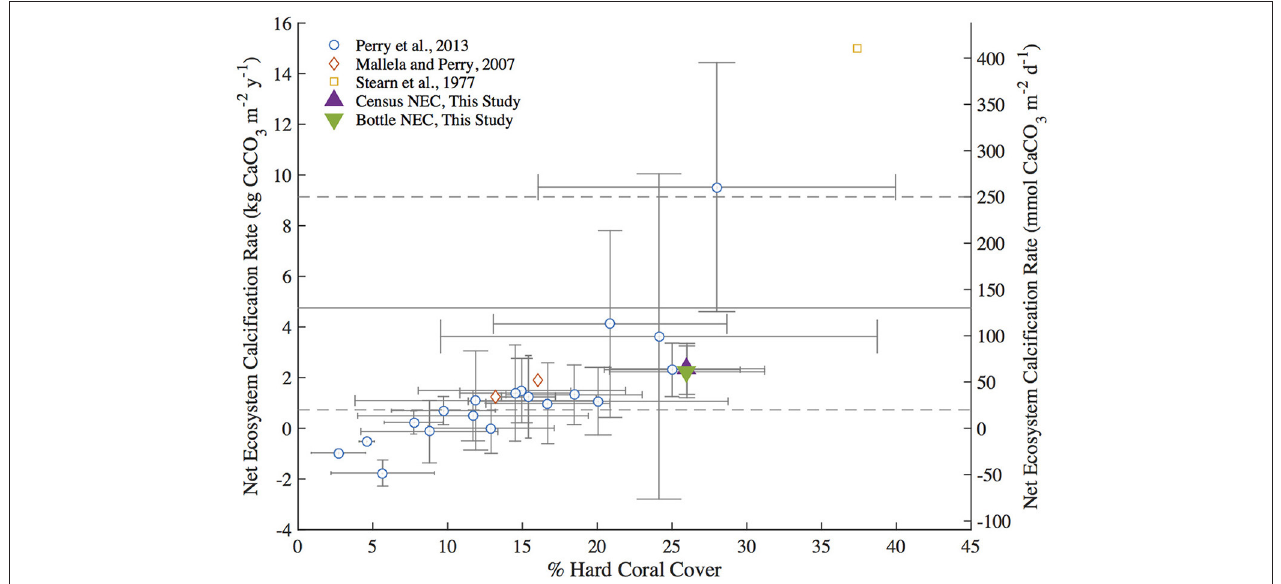
FIGURE 5 | Summary plot of Caribbean Reef percent hard coral cover vs. Net Ecosystem Calcification (NEC) adapted from Perry et al. (2013). Census NEC and bottle NEC are the 2011 integrated NEC values from this study. The gray dashed lines represent the upper and lower bounds of typical global coral reef flat NEC and the solid gray line indicates the mean global coral reef flat NEC from Atkinson